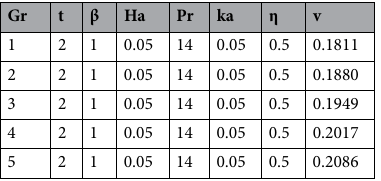
Table 5. Finite difference scheme results for different values of